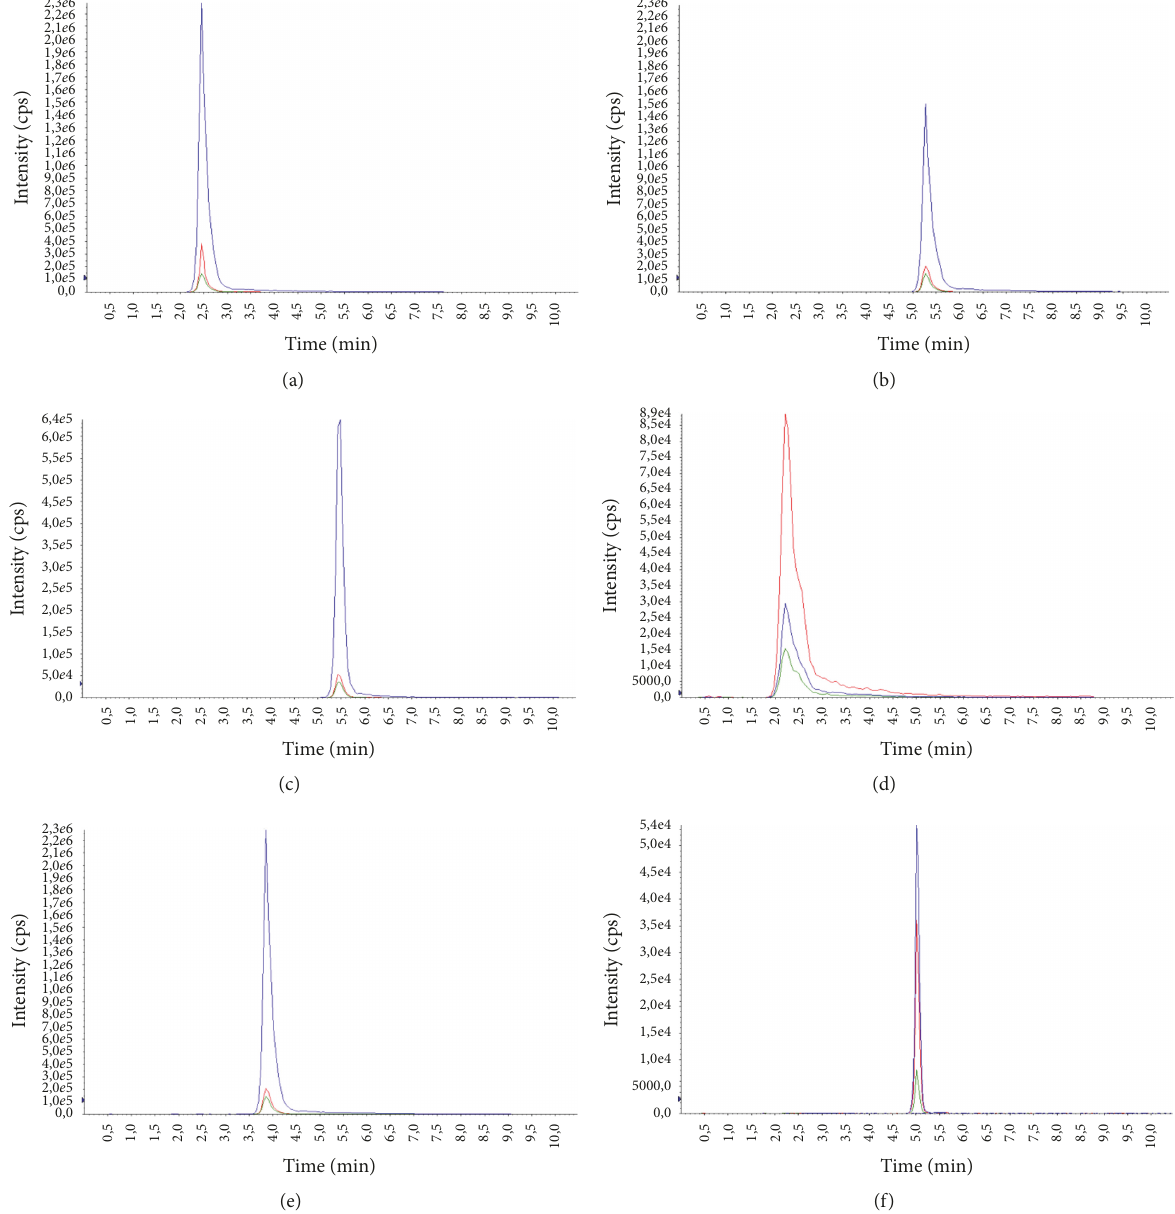
Figure 3: Representative chromatograms of patients’ plasma samples containing antipsychotics. (a) Chlorpromazine (322.52 ng/ml), (b) haloperidol (7.31 ng/ml), (c) levomepromazine (161. 83 ng/ml), (d) olanzapine (28.58 ng/ml), (e) risperidone (280.93 ng/ml), and (f) sulpiride (10.37